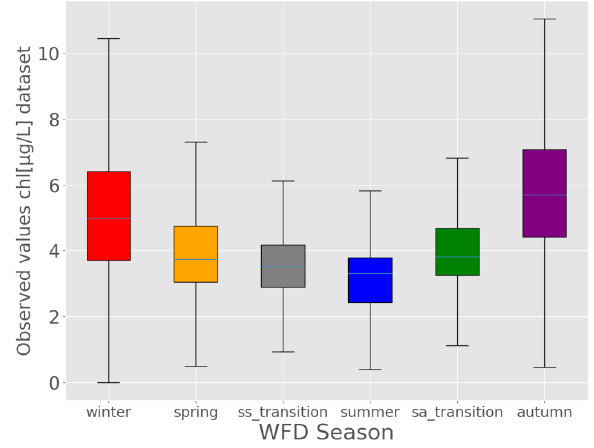
Figure 9. Boxplot per season- Chlorophyll-a (three lakes).